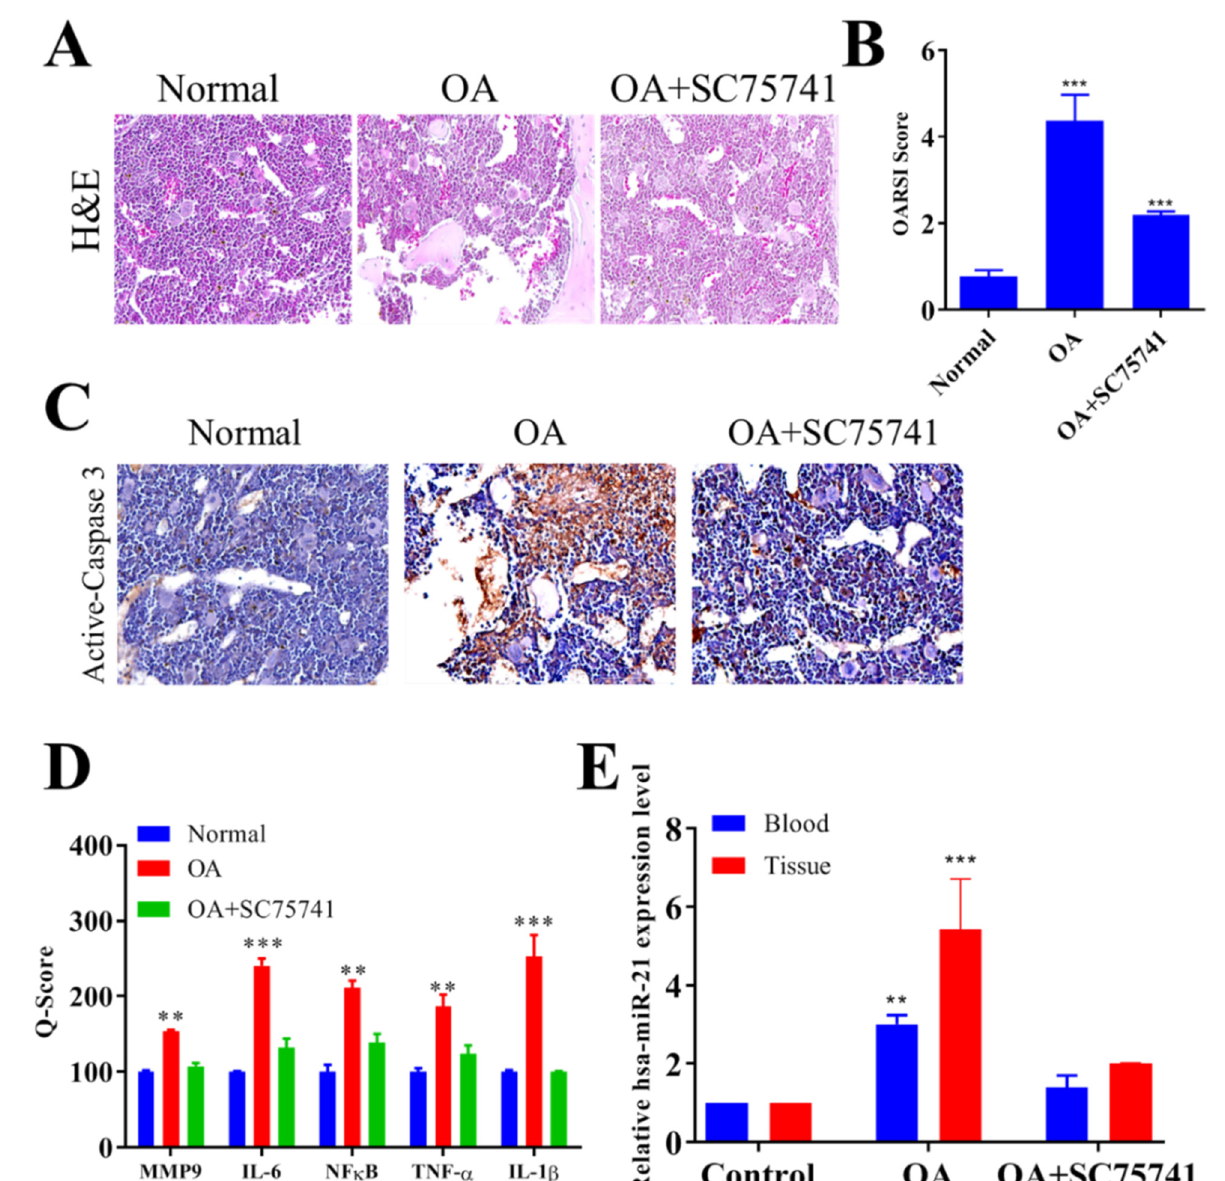
Figure 5. Histopathology of osteoarthritis of cartilage and osteoclastic activity after SC75741 treatment in the rat OA model. ( A ) H&E staining in each group at 6 weeks (magnification 20 × ). ( B ) OARSI score of each treatment group at 6 weeks. ( C ) IHC staining of cleaved caspase-3 expression in each group (magnification 40 × ). ( D ) SC75741 treatment reduced the expression of IL-6, TNF- α , and NF κ B in the SC75741-treated rats with OA. ( E ) Quantification of miR-21 expression through qRT-PCR analysis. ** p < 0.01, and *** p < 0.001.